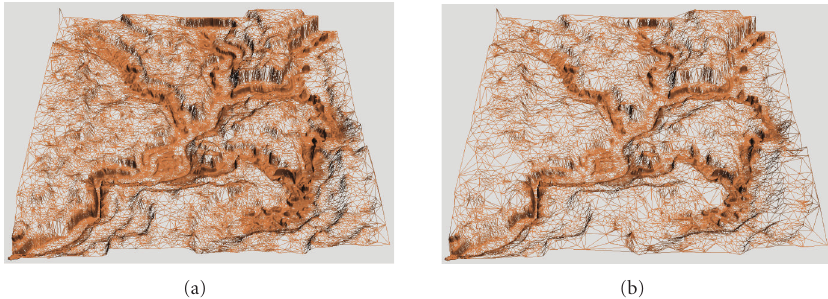
Figure 3: Output terrain mesh (a) hi-res with 175 K triangles, (b) low-res with just 75K triangles.